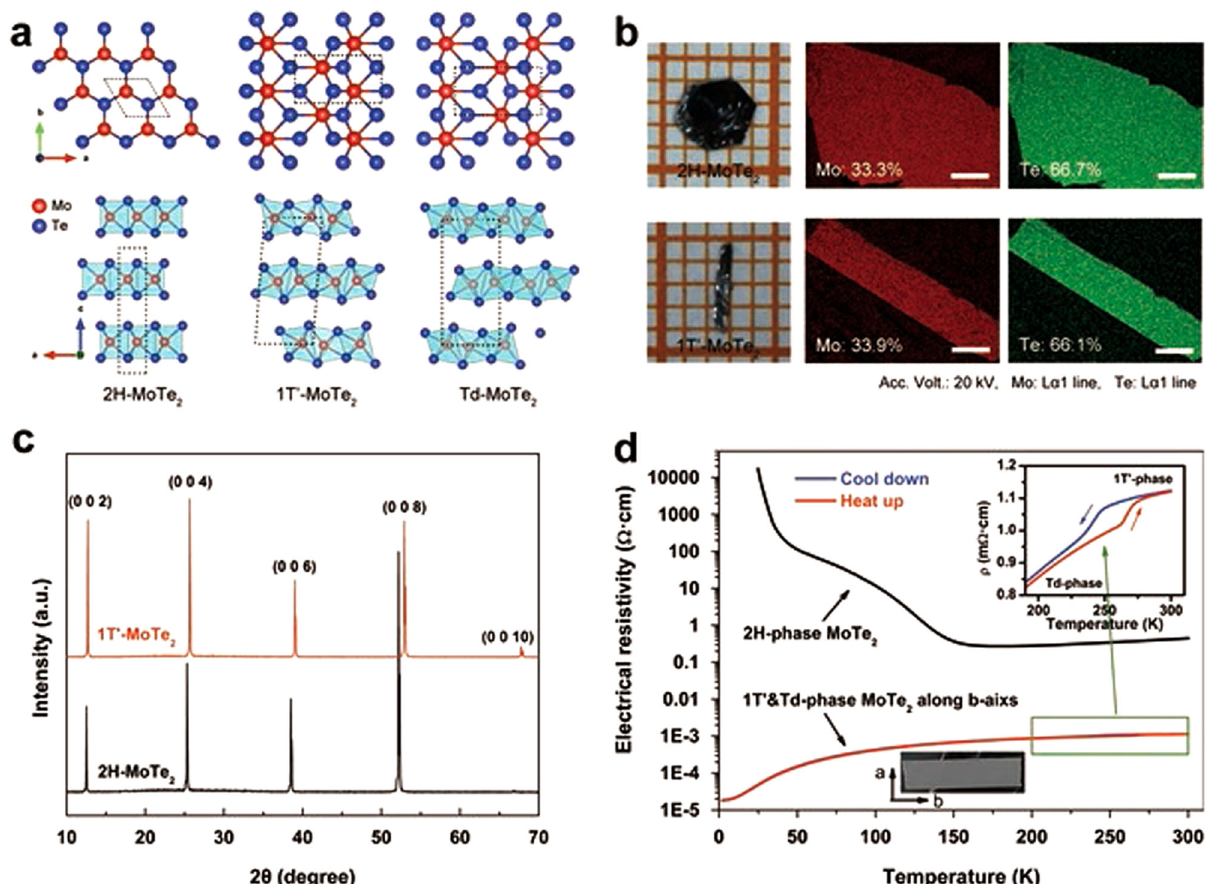
Fig. 1 a Crystal structures of 2H-phase ( α -), 1T ’ -phase ( β -) and Td-phase MoTe 2 along c -axis and b -axis. b Photographs of the as-grown MoTe 2 fl akes in the 2H-phase and 1T ’ -phases and the corresponding EDS mapping. c XRD patterns of 2H-phase and 1T ’ -phase MoTe Temperature dependence of electrical resistivity in the 2H-phase and 1T ’ -phase MoTe 2 samples along b -axis. The enlarged inset is the thermal hysteresis of electrical resistivity in the 1T ’ -phase MoTe 2 at 200 ∼ 300 K